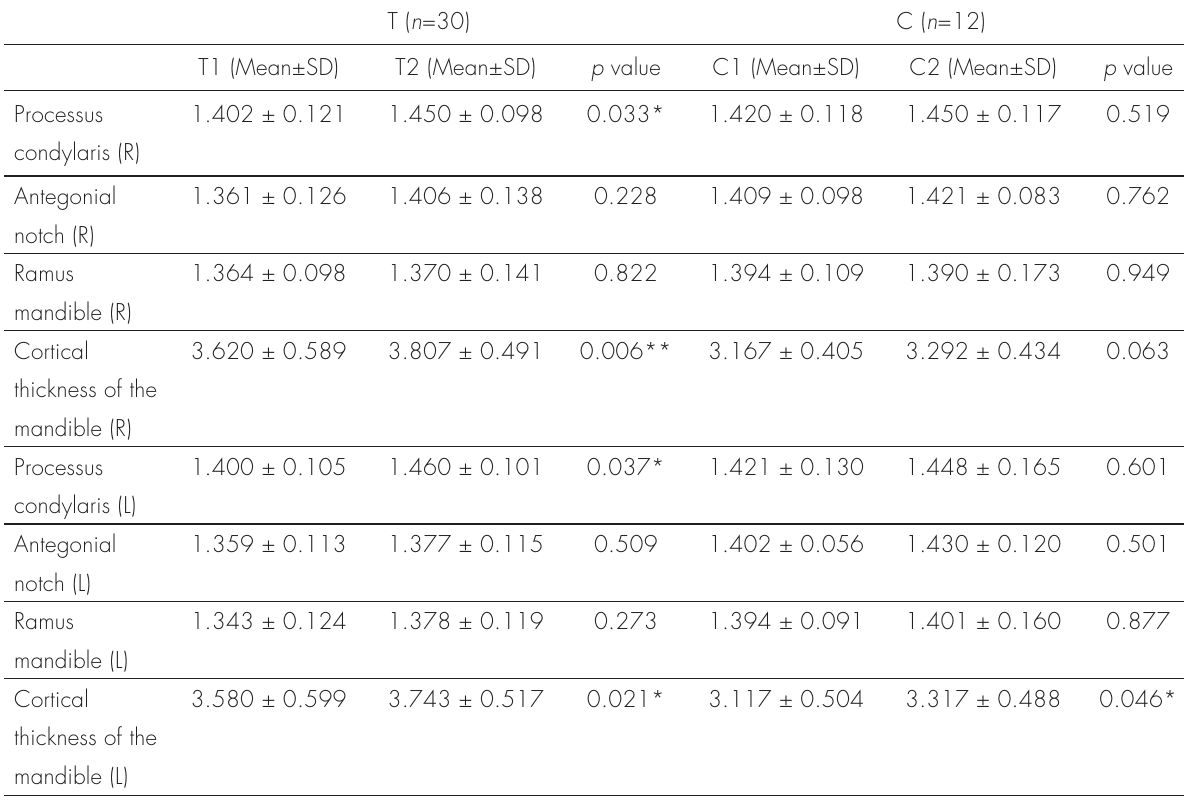
Table II. Comparisons of T1–T2 (Pretreatment – Posttreatment) and C1–C2 (Precontrol-Postcontrol) with paired t